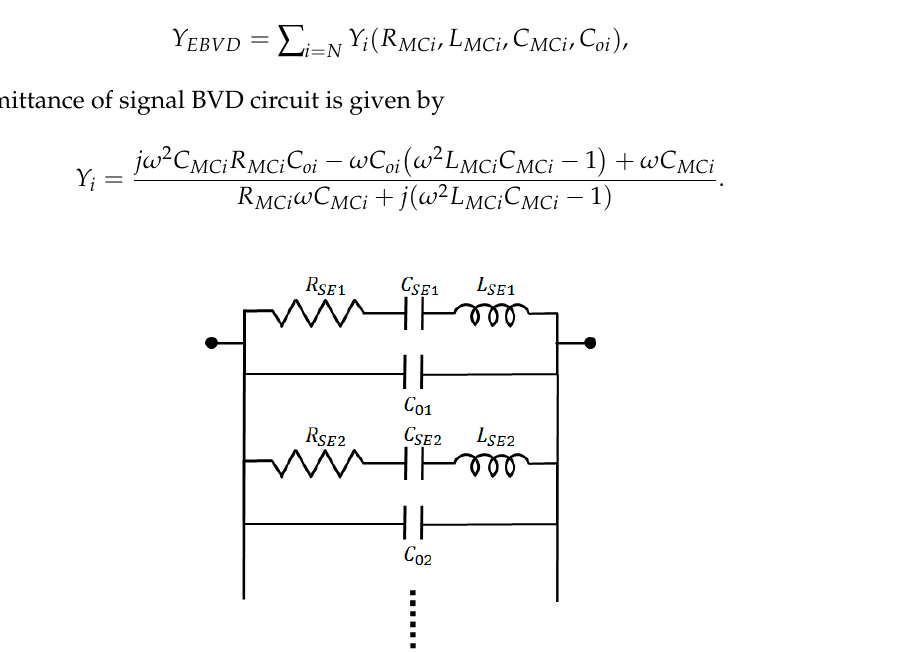
Figure 4. Electric Butterworth-Van-Dyke (BVD) model to represent an equivalent circuit of a multiple resonant frequency transducer [27].